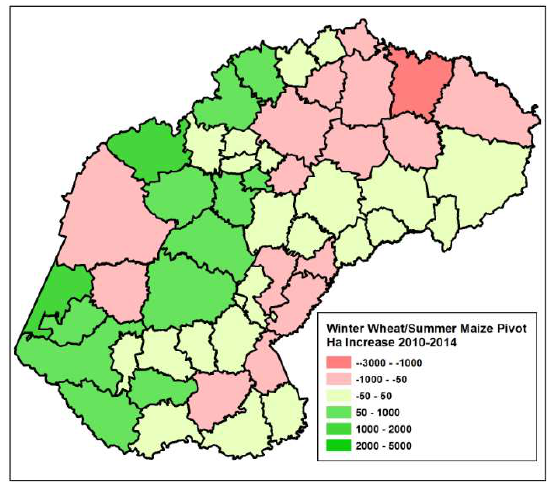
Figure 32. Double crop of wheat in winter and maize in summer area increase or decrease under pivot irrigation per district between 2010 and 2014